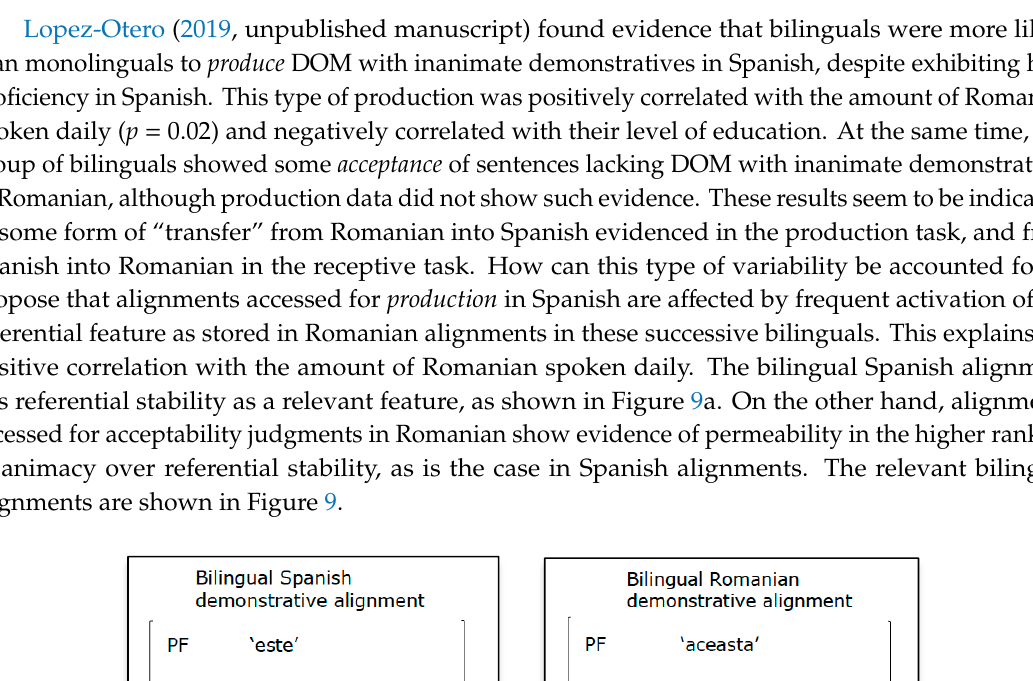
Figure 8. ( a ) Alignment for demonstrative pronouns in Spanish; ( b ) alignment for demonstrative pronouns in Romanian.